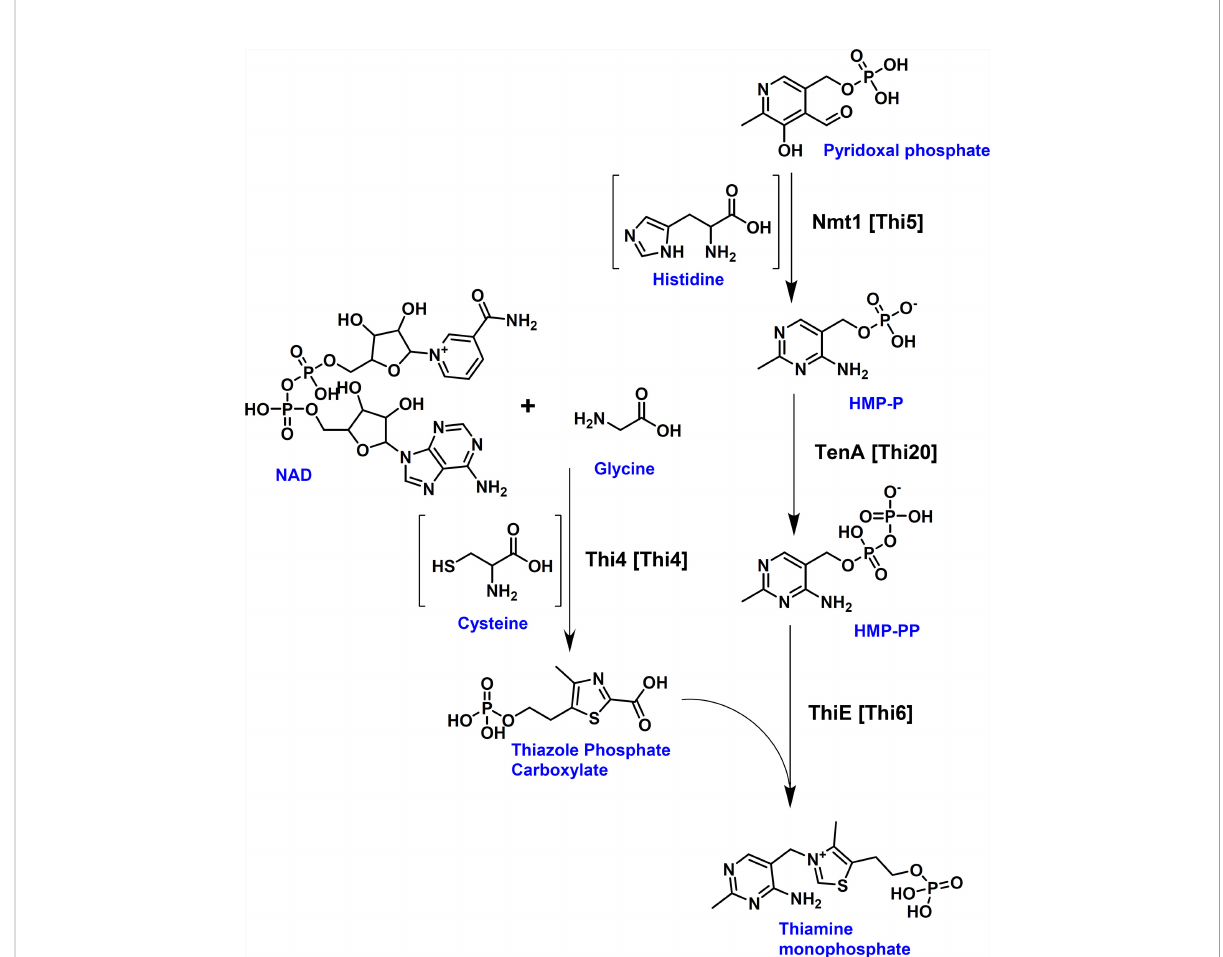
FIGURE 2 Fungal thiamine biosynthesis pathway. Aspergillus protein names are provided with corresponding yeast names given in brackets. [Thi4] = Thi4 = Thiamine thiazole synthase; [Thi5] = Nmt1 = 4-amino-5-hydroxymethyl-2-methylpyrimidine phosphate synthase; [Thi20] = TenA = phosphomethylpyrimidine kinase; [Thi6] = ThiE = hydroxyethyl thiazole kinase/thiamine-phosphate diphosphorylase. The pyrimidine and thiazole moieties are formed by two separate branches. Thi4 forms the thiazole moiety, whereby it uses the ADP-pentose moiety from NAD in combination with glycine and the sulphur group of an essential cysteine residue of Thi4 for the formation of the intermediate adenosine-diphospho-5-( b -ethyl)- 4-methylthiazole-2-carboxylic acid (not shown), from which the thiazole phosphate carboxylate is released. This results in the inactivation of Thi4 due to the loss of the sulphur group from its cysteine residue (Chatterjee et al., 2011). Nmt1 (Thi5) catalyses the initial step in the formation of the pyrimidine moiety from pyridoxal phosphate and histidine resulting in the production of 4-amino-5-hydroxymethyl-2-methylpyrimidine phosphate (HMP-P) which is phosphorylated into its pyrophosphate (HMP-PP) by TenA (Thi20). ThiE (Thi6) joins the thiazole and the pyrimidine moieties under the formation of thiamine